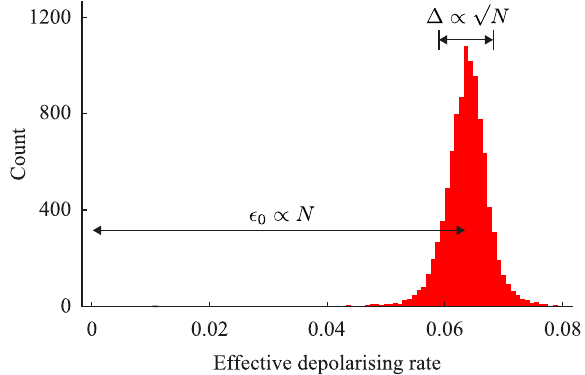
Fig. 2 Distribution of the effective depolarising rate in the phenomenological-error model. In the model, the impact of errors in a noisy circuit is characterised by the global depolarising model with the circuit-dependent depolarising rate ϵ C . The histogram is generated using six-qubit periodic-cycling circuits with 72 two-qubit gates under the gate depolarising noise. The error rate per gate is 0.001. Single-qubit gates are randomly sampled from the set of single-qubit unitaries with the weight f 2 C . The average depolarising rate is proportional to the gate number N , and the standard ffiffiffiffi p N deviation is proportional to